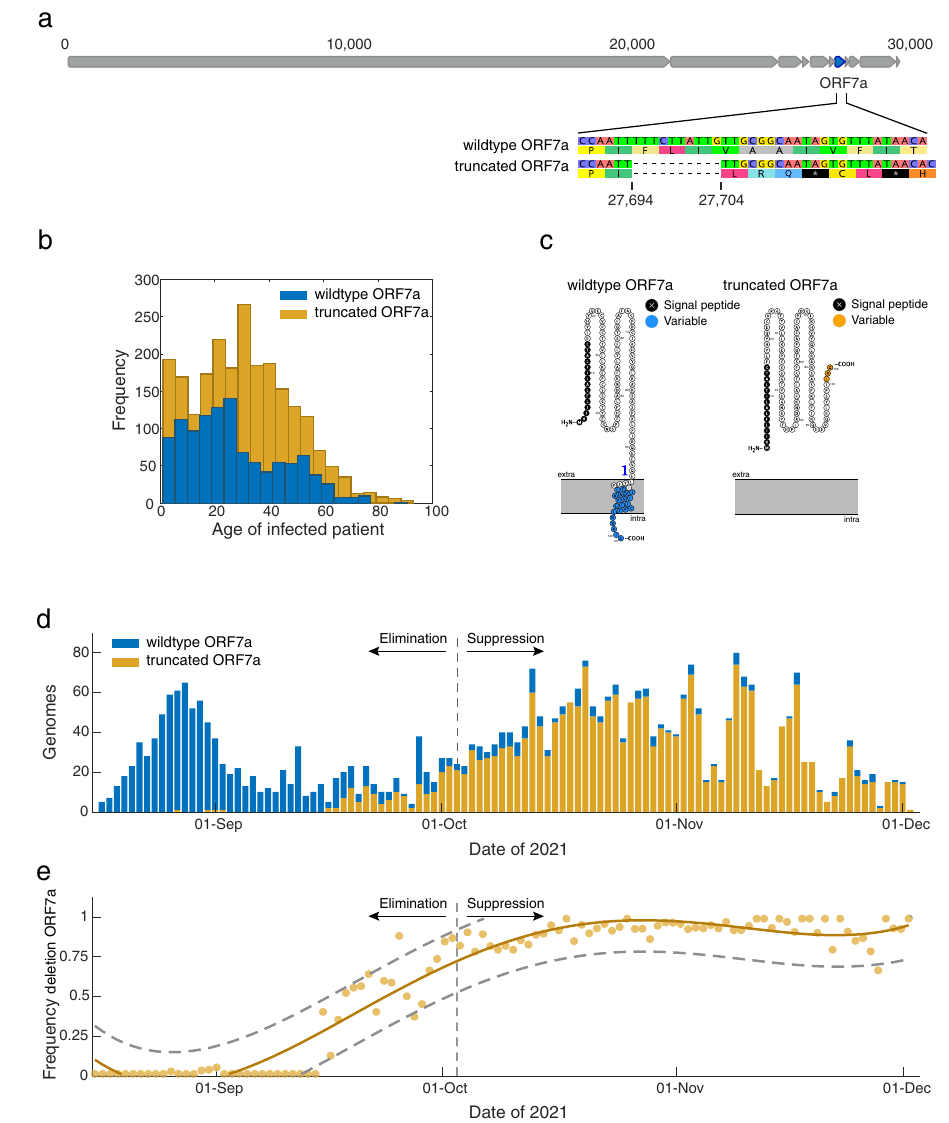
Fig. 3 Emergence of a truncated ORF7a protein. a Genome structure of SARS-CoV-2 illustrating the position of ORF7a along with an alignment showing the 10-nucleotide deletion between positions 27694 and 27704 and resulting frameshift mutation. b Age distribution of people infected with SARS-CoV-2 possessing virus genomes with (orange) and without (blue) the 10-nucleotide deletion in ORF7a. c Protein structure of the truncated and wildtype accessory protein 7a variants predicted by Protter 52 . A transmembrane helix is shown crossing the endoplasmic reticulum membrane for the wildtype variant and the variable amino acids are indicated. d Genomes sequenced through time with (orange) and without (blue) the 10-nucleotide deletion in ORF7a. e The frequency of genomes with the truncated ORF7a peptide (orange line), a 95% prediction interval (grey dashed lines) and the raw data (orange points) over